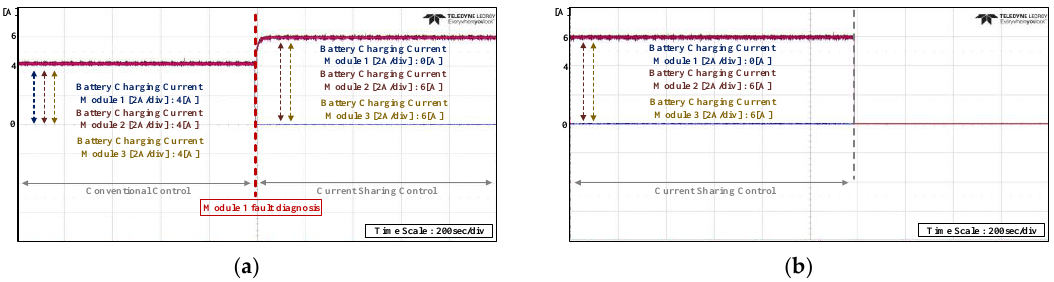
Figure 19. The battery charge current waveform when fault module occurs. ( a ) Sharing of fault module current sharing, ( b ) current waveform at end of charge.